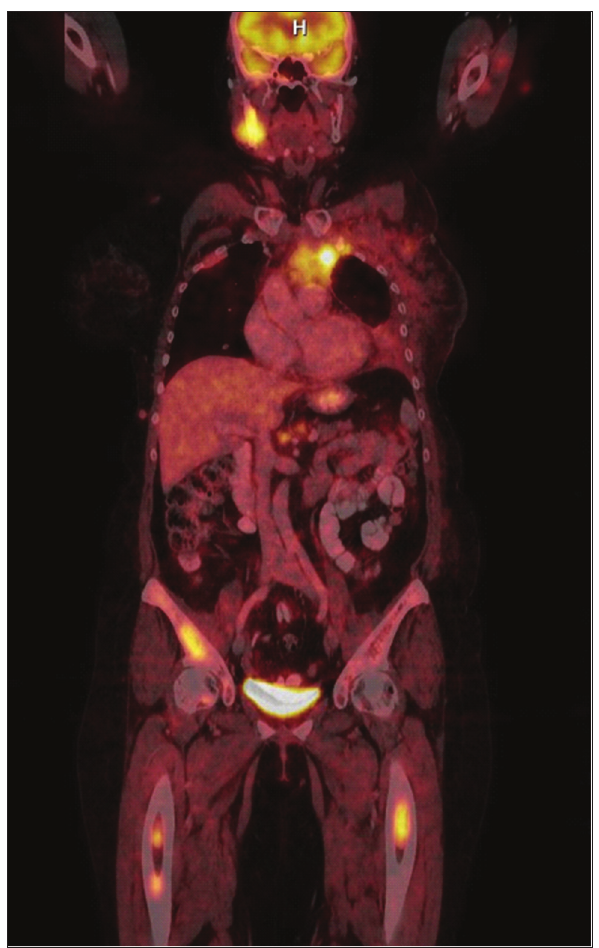
Fig. 1. 18F-FDG PET/CT revealed glucose hypermetabolism in the right mandible and adjacent soft tissues, mediastinum, bone marrow in the iliac crest and both femurs.